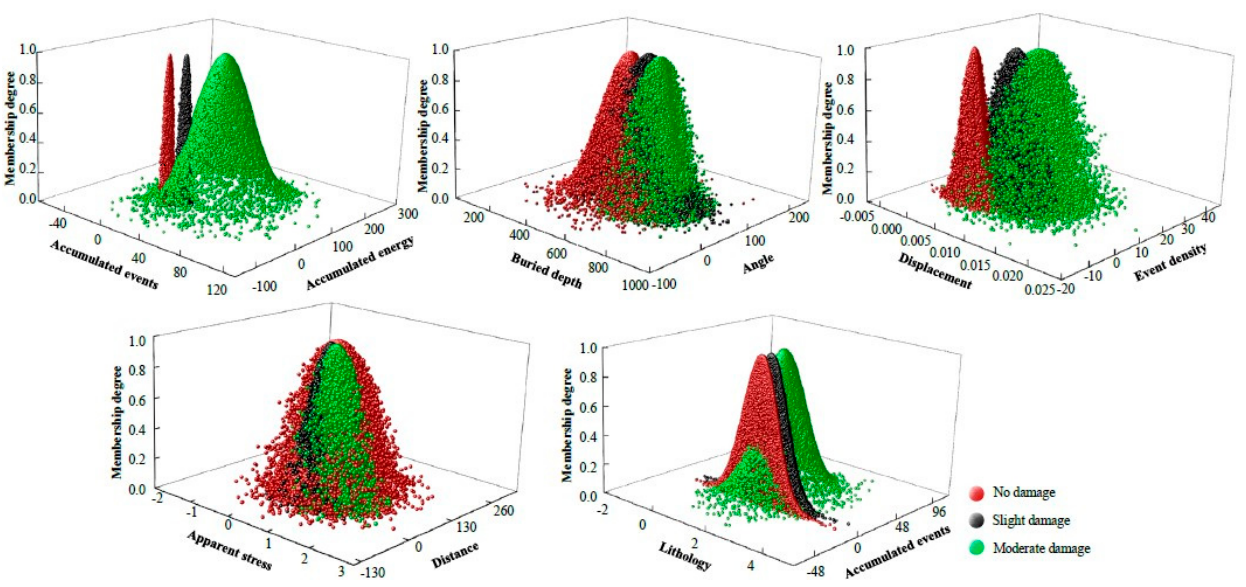
Figure 9. Clustering of the evaluation indexes of different damage levels generated by the cloud models.